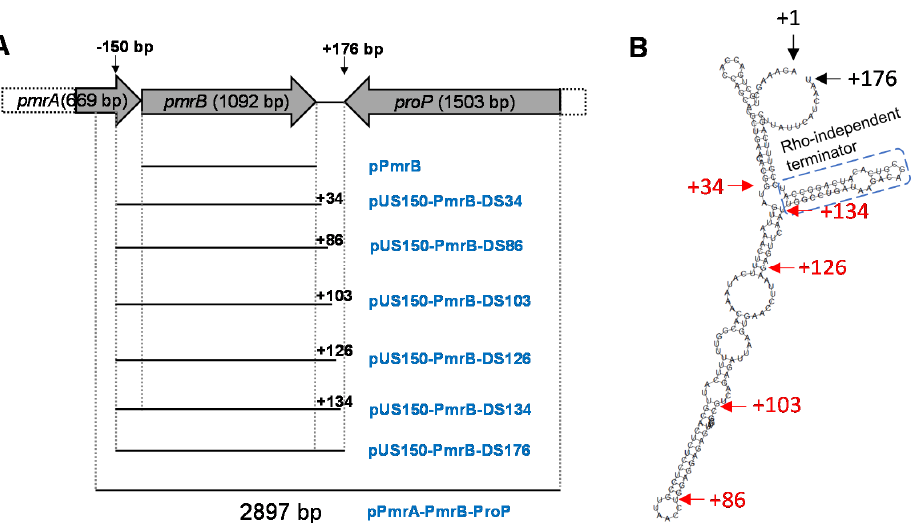
Figure 1. Diagram of subcloning strategy and the predicted stem-loop structure of 3′-downstream region of pmrB . ( A ) Stepwise subcloning and corresponding plasmid constructs (plasmid name in blue). Vertical dash lines cover the cloned major regions selected for subcloning. − 150 bp, 150 bp upstream of pmrB ORF. The length of region downstream of pmrB ORF in different constructs was indicated by the number with “+” prefix. ( B ) Stem-loop structure prediction of 3′-downstream region of pmrB . The starting (+1) and ending (+176) of the 3′-downstream region of pmrB are indicated with black arrows. The transition sites between some stems and loops are indicated with arrows followed by the distance from the pmrB stop codon (in red); these sites were also selected for creating subcloning plasmids (detailed in A panel). The blue dash box indicates predicted Rho- independent terminator.